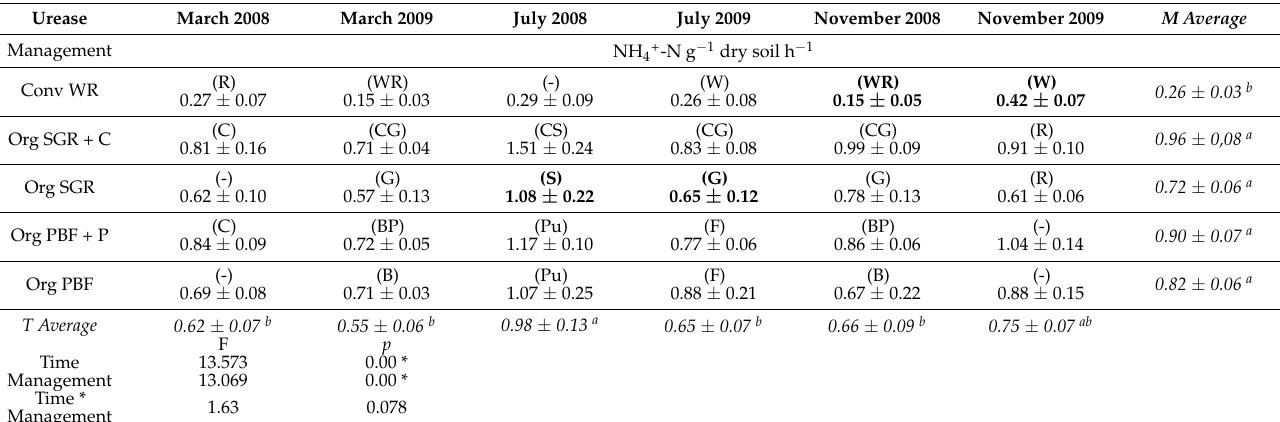
Table 9. Urease enzymatic activity in